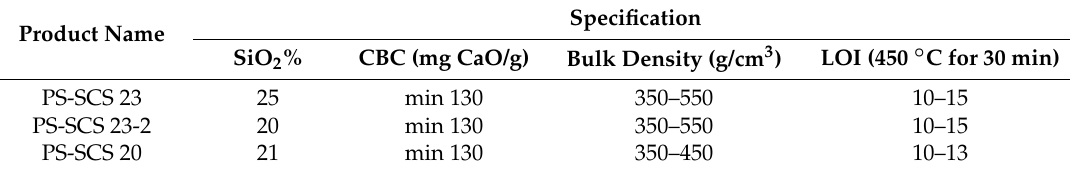
Table 2. Technical specification of various SCS types. (CBC: representative of CaO content (mg) in 1 g SCS).